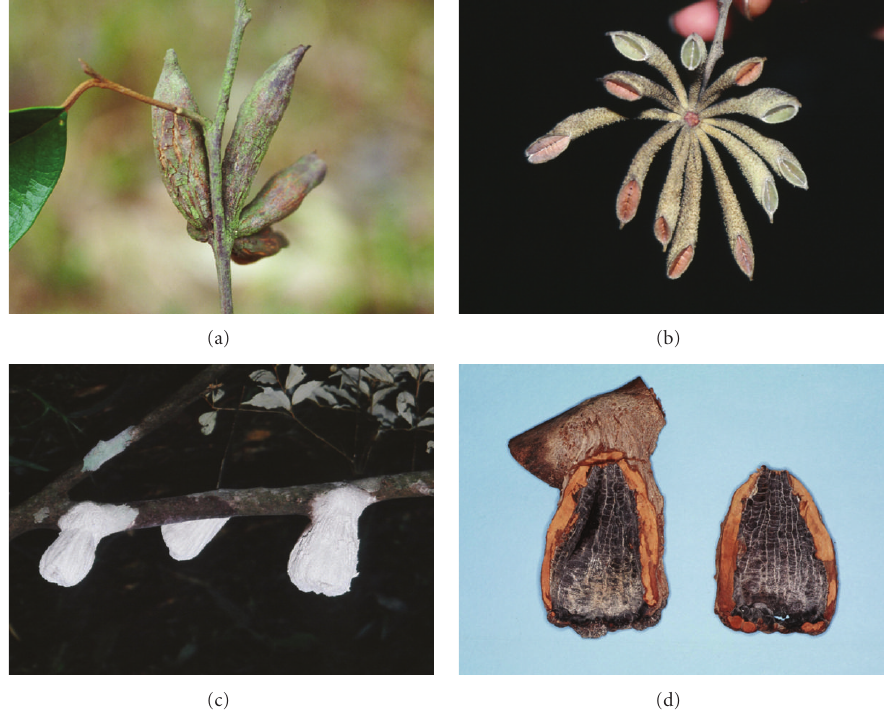
Figure 11: (a) A lignified (live) gall of Pseudoregma koshunensis on Styrax suberifolius (Sun Moon Lake, Taiwan; 3 June 1992). (b) A gall of Astegopteryx styracophila on Styrax benzoin (Urung Tama, Sumatra; 28 February 1994). (c) Three galls of Cerataphis jamuritsu on a thick branch of S. suberifolius (Hsinhua, Taiwan; 3 November 1994). (d) A cut gall of C. jamuritsu , indicating its thick wall (the rightmost gall in (c); dried after being kept in